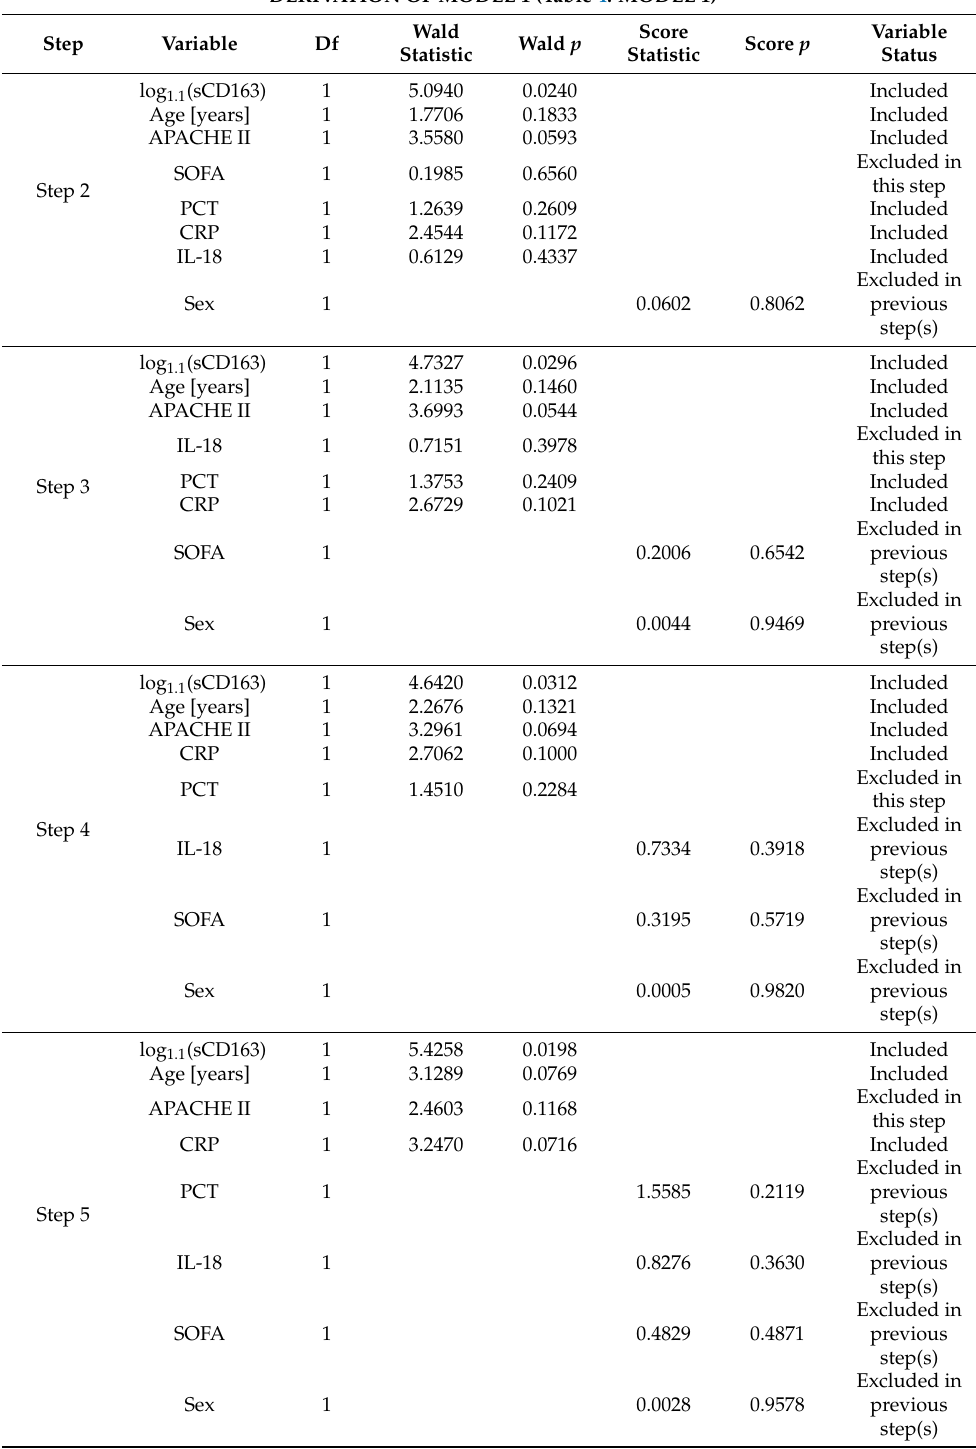
Table A3. Cont. DERIVATION OF MODEL 1 (Table 4: MODEL